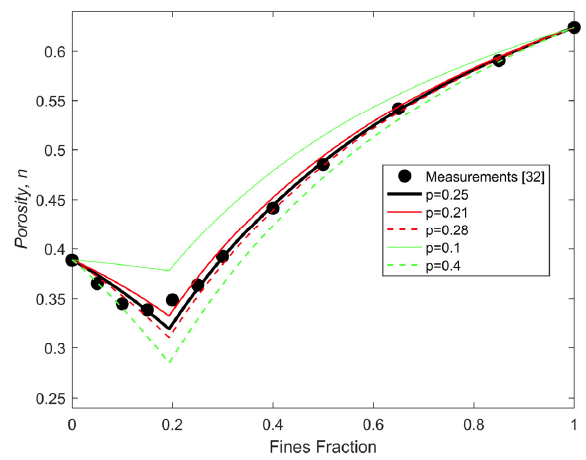
Figure 10. Porosity as function of fines fraction for sand–Kaolinite mixtures from [32]. The different curves were produced using the presented model (Equations (11)–(18)) for different p values. The average value reported based on all mixtures examined is 0.25 (black solid curve) while the red curves show the upper and lower values of the feasible range. Green curves are for p values far the feasible range showing unsatisfactory prediction.